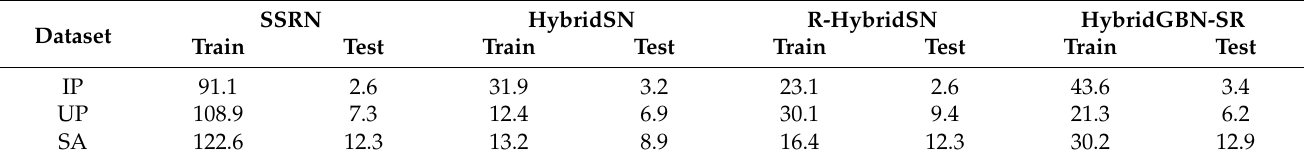
Table 10. The training and testing time in seconds over IP, UP, and SA datasets using SSRN, HybridSN, R-HybridSN, and